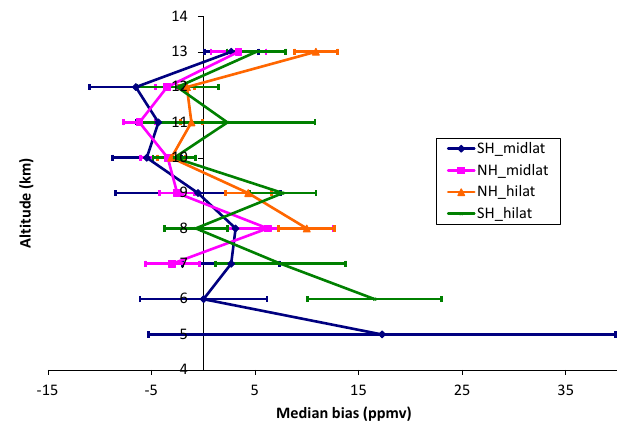
Figure 14. Same as Fig. 12 but only for high and mid-latitude re-